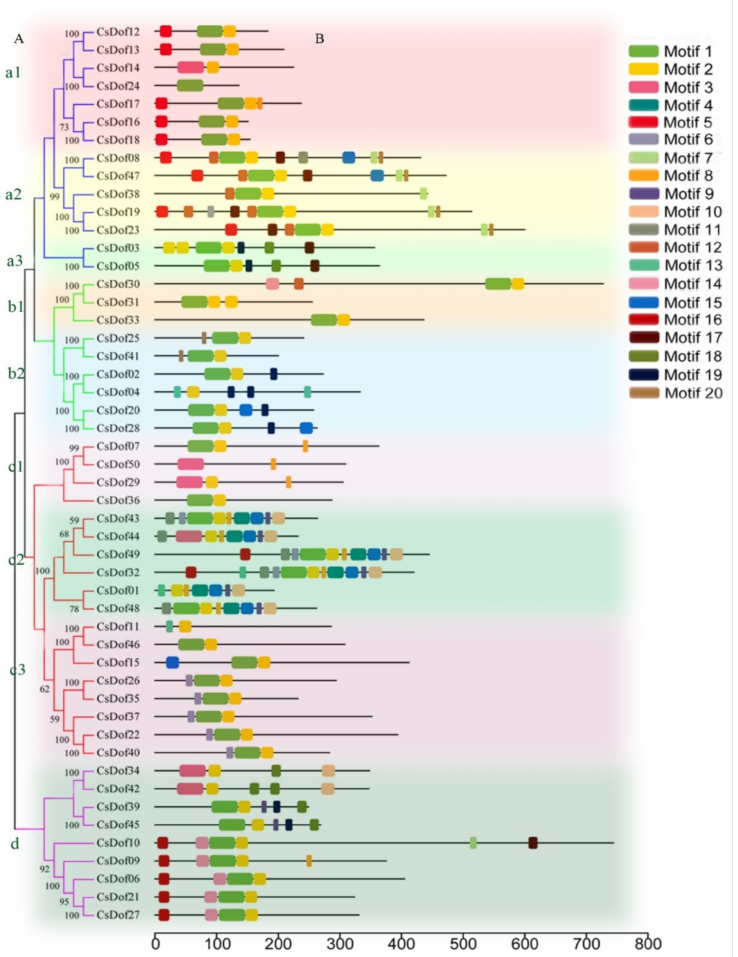
Figure 4. ( A ) Phylogenetic analysis of the CsDof genes. The phylogenetic tree was constructed using the NJ method (1000 bootstrap replicates). ( B ) Distribution of conserved motifs in the CsDof proteins. Conserved motifs were identified using the MEME program and indicated in numbered colored boxes, where Motif 1, Motif 3, and Motif 2 include the conserved Dof domain. The blue, green, red, and pink branches represent groups a, b, c, and d, respectively. Groups a, b, and c were further divided into subgroups a1, a2, a3, b1, b2, c1, c2, and